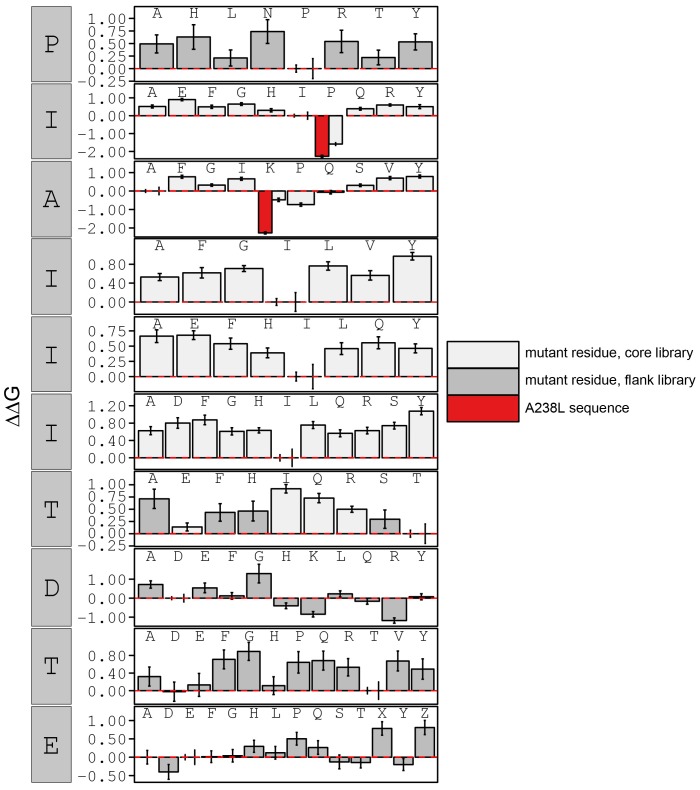
ΔΔG calculated in reference to peptide KRMEPIAIIITDTEIS.Peptide sequence KRMEPKIIITTDTEIS (red) contains a PxIxIT motif equivalent to the A238L viral inhibitor. Phosphoserine and phosphothreonine are represented by 'X' and 'Z', respectively.